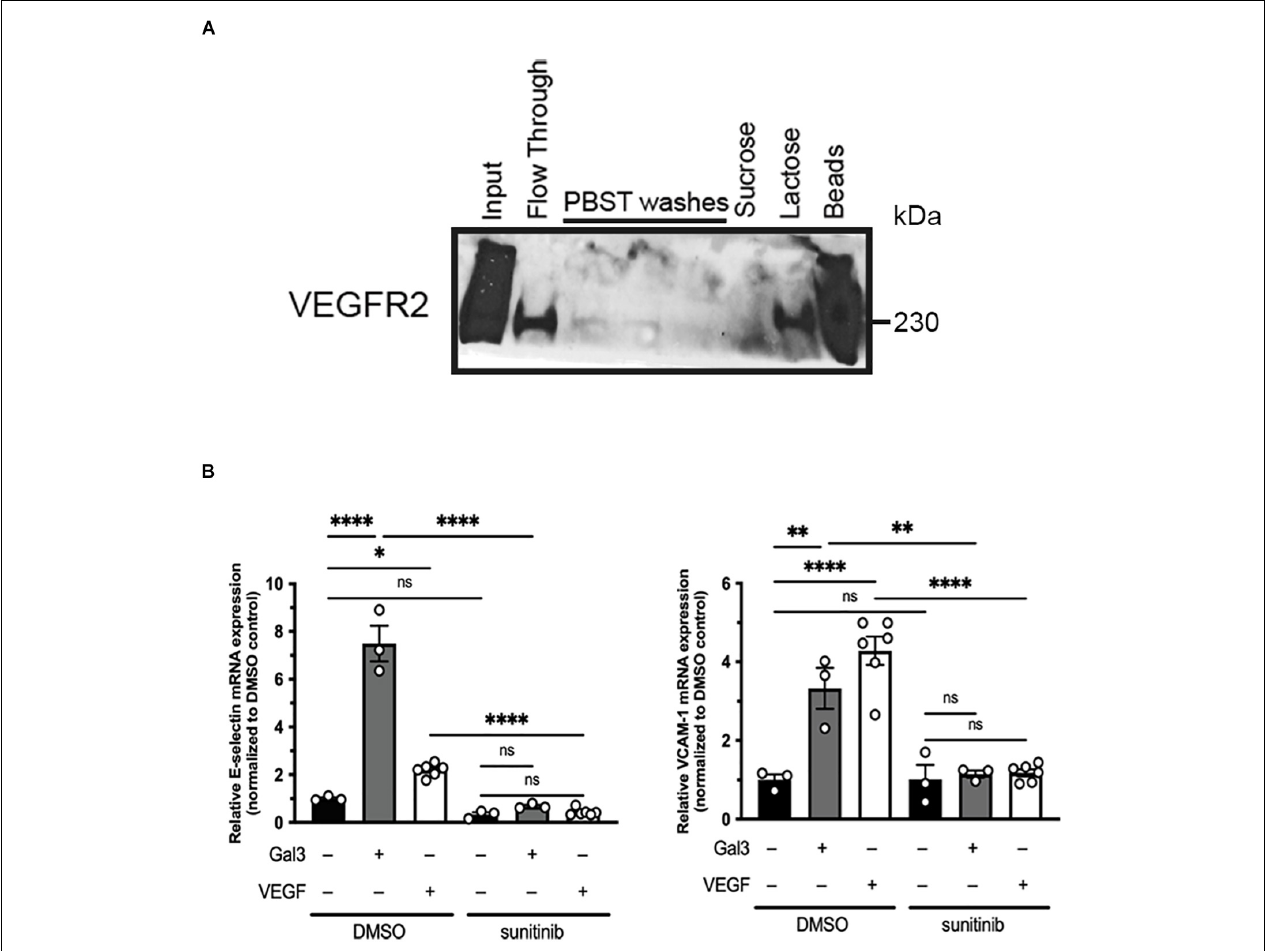
FIGURE 1 | Galectin-3 associates with and induces activation of VEGFR2. (A) Confluent HRECs were lysed using RIPA lysis buffer. HREC lysate was incubated with Gal3-conjugated beads, washed, and eluted either with a non-competitive sugar (0.1 mM sucrose) or a competitive sugar (0.5 mM lactose). Bound VEGFR2 was eluted once it was competed off of the beads by lactose (B) Serum-starved HRECS were stimulated with 50 µ g/ml Gal3 or 10 ng/ml VEGF for 2 h with or without sunitinib then total RNA was isolated and reverse transcribed into cDNA. E-selectin, VCAM-1, and HPRT1 mRNA expression were analyzed using qPCR. One-way ANOVA analysis was applied, ∗ P < 0.05, ∗∗ P < 0.01, ∗∗∗∗ P < 0.0001, n =